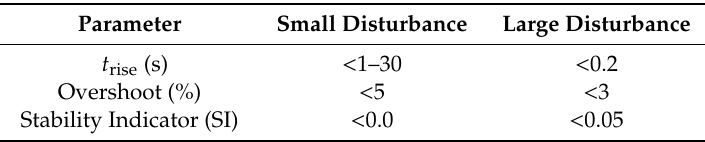
Table 2. Performance indicator parameter specification.